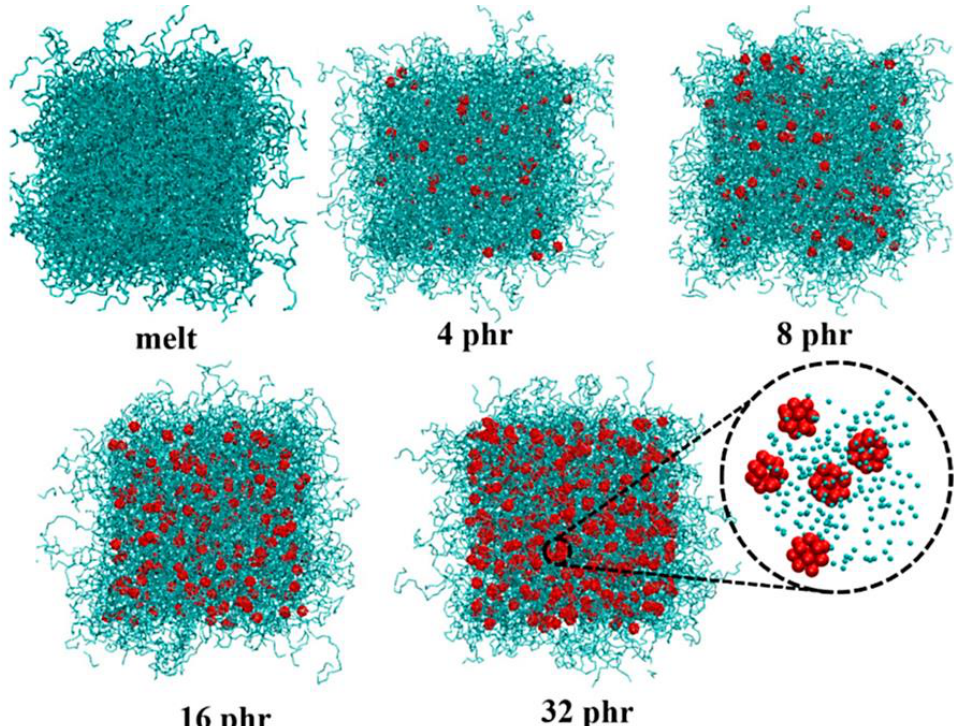
Figure 3. Snapshots of cis-1,4-polyisoprene and C 60 -based nanocomposite membranes with varying nanofiller contents from 0 (melt) to 32 phr [153]. Reproduced with permission Creative Commons Attribution License.